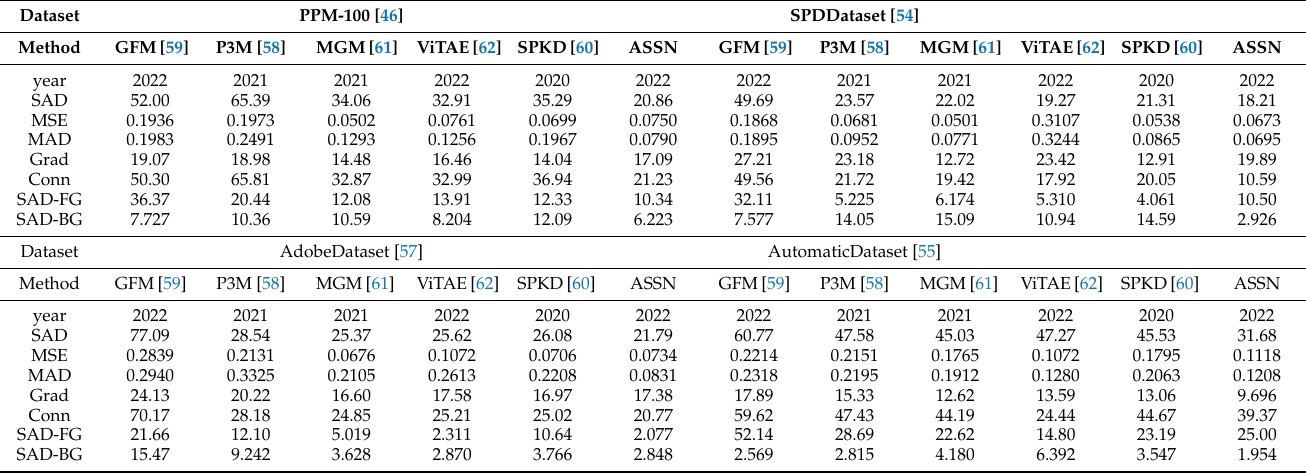
Table 3. The results of our approach compared with recent architectures on four different